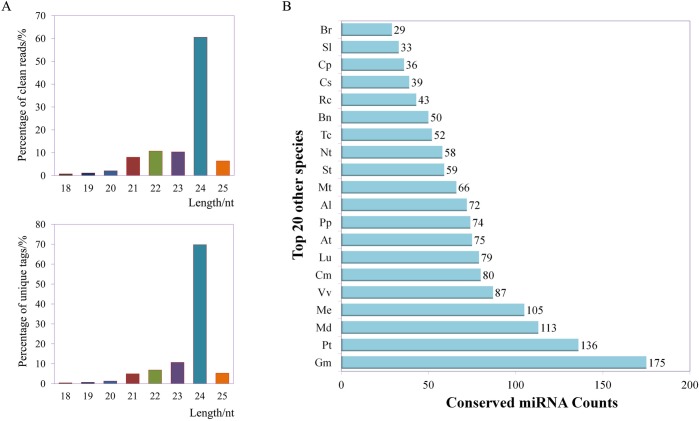
Analysis of sequence length and conservation of miRNAs.(A)Distribution of small RNAs with different sequence length according to clean reads and unique tags. (B) Conservation of the identified miRNAs with those in other species. The x-axis represents the number of conserved miRNAs and the y-axis indicates the top 20 number in other species. Different prefixes indicating different species are as follows: Br-Brassica rapa; Sl-Solanum lycopersicum; Cp-Carica papaya; Cs-Citrus sinensis; Rc-Ricinus communis; Bn-Brassica napus; Tc-Theobroma cacao; Nt-Nicotiana tabacum; St-Solanum tuberosum; Mt-Medicago truncatula; Al-Arabidopsis lyrata; Pp-Prunus persica; At-Arabidopsis thaliana; Lu-Linum usitatissimum; Cm-Cucumis melo; Vv-Vitis vinifera; Me-Manihot esculenta; Md-Malus domestica; Pt-Populus trichocarpa; Gm-Glycine max.